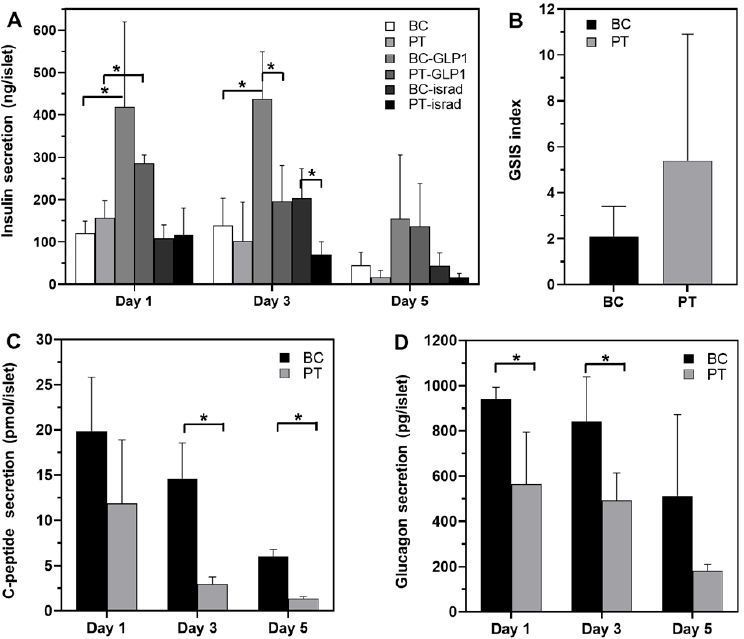
Figure 2. Hormone secretions in biochip (BC) and Petri (PT) throughout the 5 days of culture. ( A ) insulin secretion in control and after exposure to GLP-1 and isradipine (biochip and Petri); ( B – D ) glucagon, C-peptide secretions and GSIS index (biochip and Peri control), respectively. GSIS: glucose-stimulated insulin secretion index = insulin measured in high-glucose/insulin measured in low-glucose. * p < 0.05.